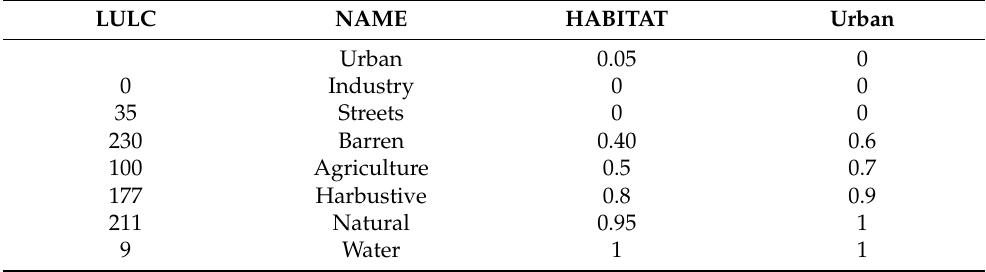
Table 4. Habitat Quality modelling. Sensitivity values for each Land Use in the input .csv table. LULC NAME HABITAT Urban